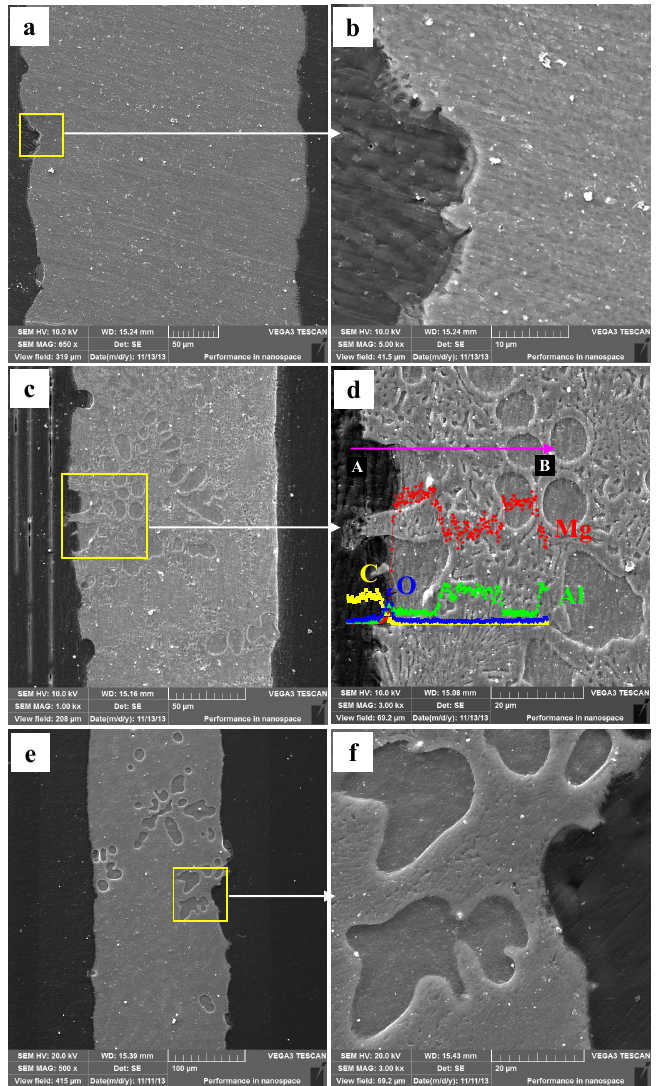
Figure 8. The corroded Mg–Al alloy specimen’s cross-sectional morphologies obtained from H 2 SO 4 solution for different immersion times: ( a , b ) 30 min; ( c , d ) 60 min; ( e , f ) 90 min.